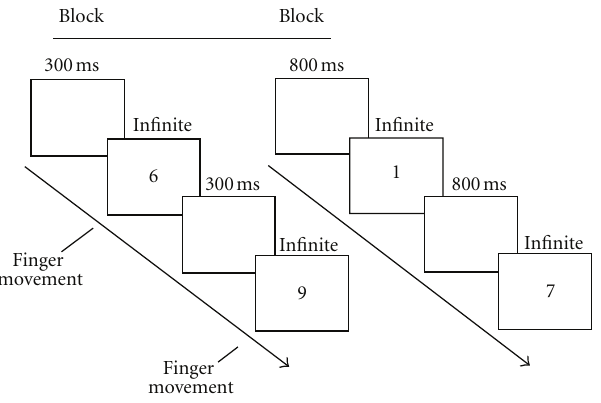
Figure 1: Example of typical trial